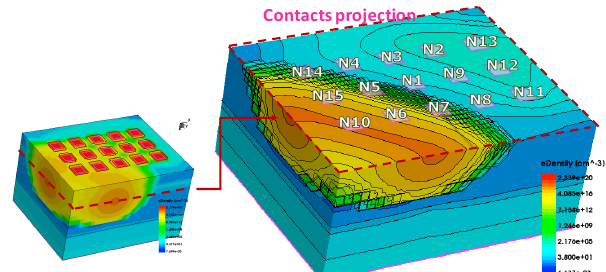
Fig. 8. Aluminum generation in the 15-pixels matrix. The figure on the right is a cut at depth=0.8 µ m. The represented contacts are a projection of the fifteen top contacts.